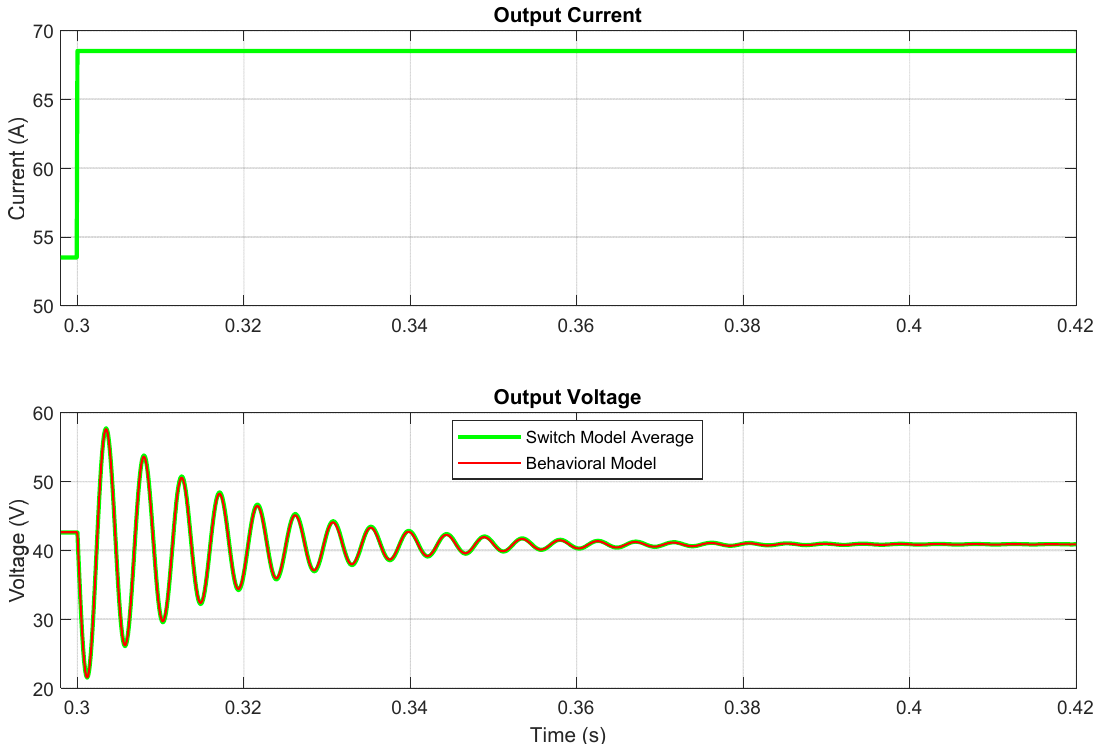
Figure 9. Output voltage waveforms comparison for step change in output current.